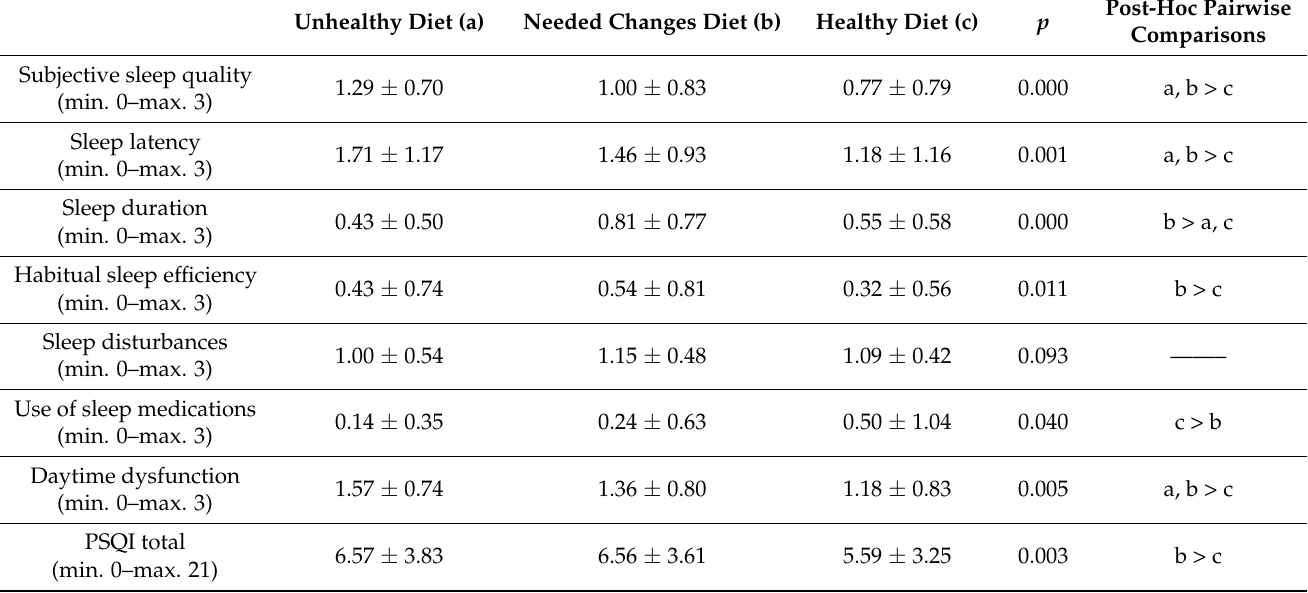
Table 3. Relationship between diet quality and presence of poor sleep quality (PSQI score > 5).